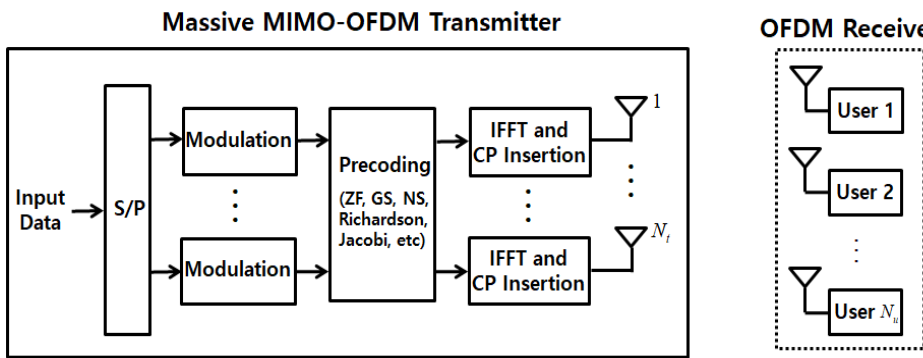
Figure 1. The downlink multi-user (MU) massive MIMO-OFDM system model. S/P: serial to Parallel; ZF: zero-forcing; GS: Gauss–Seidel; NS: Neumann series; IFFT: inverse fast Fourier transform; CP: cyclic prefix.